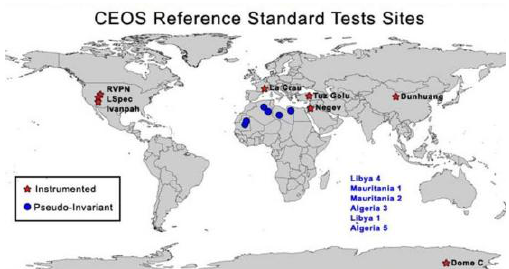
Figure 1. CEOS Reference Standard Test Sites (Fox, 2010)